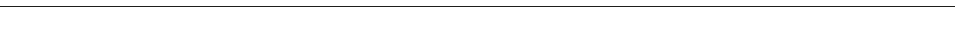
Fig. 4 Local RGD density thresholds for adhesion formation and cell tethering to substratum. a dSTORM images of RGD ligands on ITO surfaces and paxillin in NIH-3T3 cells. NIH-3T3-cells-expressing paxillin fused to mEos2 were plated onto ITO surfaces that were functionalised with RGD-A647 and RGE peptides at the indicated ratios. Top: TIRF images of paxillin-mEos2; scale bar = 10 µ m. Middle and bottom: Merged PALM images of paxillin-mEos2 (green) and dSTORM images of RGD-A647 peptides (red); scale bar = 10 µ m. Zoomed regions of individual adhesions are shown in the second and third row; scale bar = 1 µ m. Images are representative images of n = 3 − 4 independent experiments. b RGD density averaged over the entire surface (black bars) and averaged over the area occupied by cells (grey bars) obtained from dSTORM images of RGD-A647 on ITO surfaces with various ratios of RGD-A647: RGE. Bars and error bars are mean and standard deviation, respectively of n = 5 independent experiments; ns not signi fi cant; * P ≤ 0.05, ** P < 0.01, *** P < 0.001 and **** P < 0.0001 (paired t test). c Density of paxillin-mEos2 in adhesive structures (black bars) and outside adhesive structures (grey bars) in NIH-3T3 cells on ITO surfaces with various densities of RGD-A647:RGE. Paxillin-mEos2 densities in versus out of adhesive structures were signi fi cantly different on all surfaces (**** P < 0.0001, unpaired t test) while paxillin-mEos2 inside adhesive structures was dependent on the RGD-A647:RGE ratio, except where indicated as ns, not signi fi cant (one-way ANOVA with Tukey post-testing). d Density of RGD-A647 in adhesive paxillin-mEos2 structures (black bars) and outside adhesive structures (grey bars) in NIH-3T3 cells on ITO surfaces with various densities of RGD-A647:RGE. RGD-A647 densities in versus out of adhesive structures were not statistically signi fi cant for all surfaces (unpaired t test, not shown) while RGD-A647 densities on 1:0 RGD:RGE surfaces was signi fi cantly higher in and out of adhesive structures compared to other presented (*** P < 0.001, **** P < 0.0001, one-way ANOVA with Tukey post-testing). In b − d , data are average and standard deviation from n = 3 − 4 independent